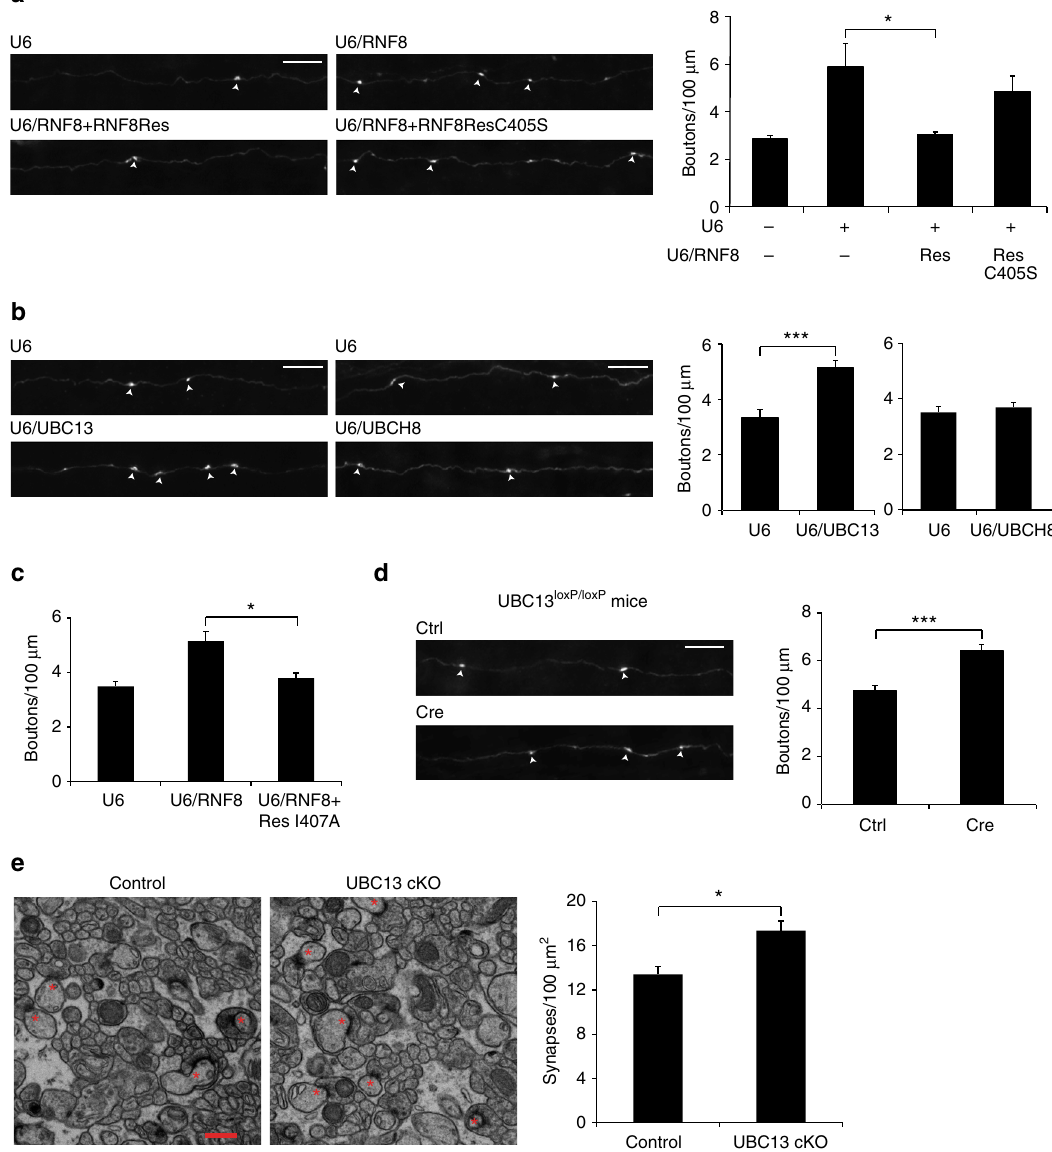
Fig. 4 The ubiquitin-conjugating E2 enzyme UBC13 operates with RNF8 to suppress presynaptic differentiation in vivo. a P4 rat pups were electroporated with the control U6 plasmid or RNF8 RNAi plasmid together with an expression plasmid encoding RNF8Res, RNF8Res in which C405 was mutated to serine (RNF8ResC405S), or the control vector and with the GFP expression plasmid and analyzed as in Fig. 1a. RNF8Res, but not RNF8ResC405S, reversed the RNF8 RNAi-induced phenotype of increased presynaptic bouton number in vivo (* p < 0.05, ANOVA followed by Fisher ’ s PLSD post hoc test, n = 3-4 rats). b P4 rat pups were electroporated with the UBC13 RNAi, UBCH8 RNAi, or control U6 plasmid and analyzed as in Fig. 1a. Knockdown of UBC13, but not knockdown of UBCH8, increased the density of presynaptic parallel fi ber boutons in the cerebellar cortex in vivo (*** p < 0.005, t test, n = 3 rats). c P4 rat pups were electroporated with the control U6 plasmid or RNF8 RNAi together with a RNF8Res mutant in which isoleucine 407 was replaced with alanine (RNF8ResI407A) or the control vector and with the GFP expression plasmid and analyzed as in Fig. 1a. Expression of RNF8ResI407A reversed the RNF8 knockdown-induced phenotype on presynaptic boutons (* p < 0.05, ANOVA followed by Fisher ’ s PLSD post hoc test, n = 3 – 6 rats). For representative images of axons see Supplementary Fig. 6c. d P6/7 UBC13 loxP / loxP mice were electroporated with the Cre expression plasmid or control vector together with the GFP expression plasmid and analyzed as in Fig. 1a. Cre-induced knockout of UBC13 in granule neurons increased presynaptic bouton density in vivo (*** p < 0.001, t test, n = 6 mice). Scale bars = 10 μ m. e The cerebellum from P25 UBC13 conditional knockout mice and control UBC13 loxP / loxP mice were subjected to electron microscopy analyses. Left: representative electron micrographs of the molecular layer of the cerebellar cortex. Parallel fi ber presynaptic bouton/Purkinje cell synapses are denoted by asterisks. Scale bar = 500 nm. Right: quanti fi cation of the density of granule neuron parallel fi ber/Purkinje cell synapses in UBC13 cKO and control mice. Knockout of UBC13 induced an increase in the density of parallel fi ber/Purkinje cell synapses compared to control mice (* p < 0.05, t test, n = 3